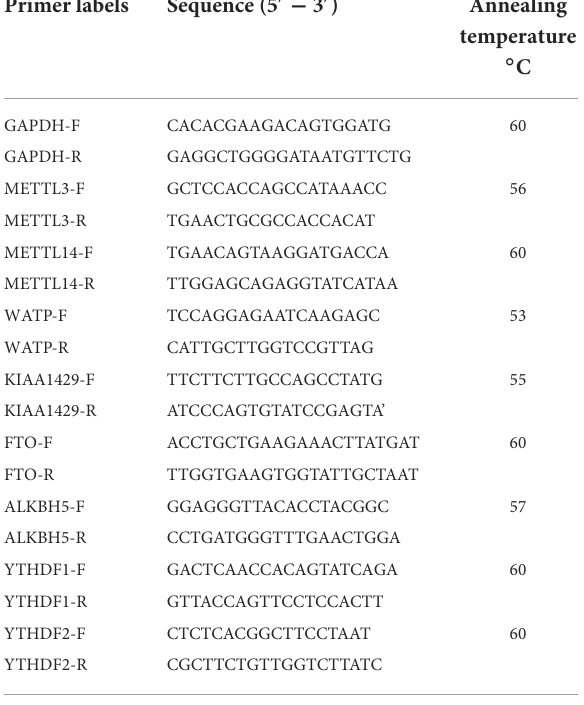
TABLE 1 Primers information of